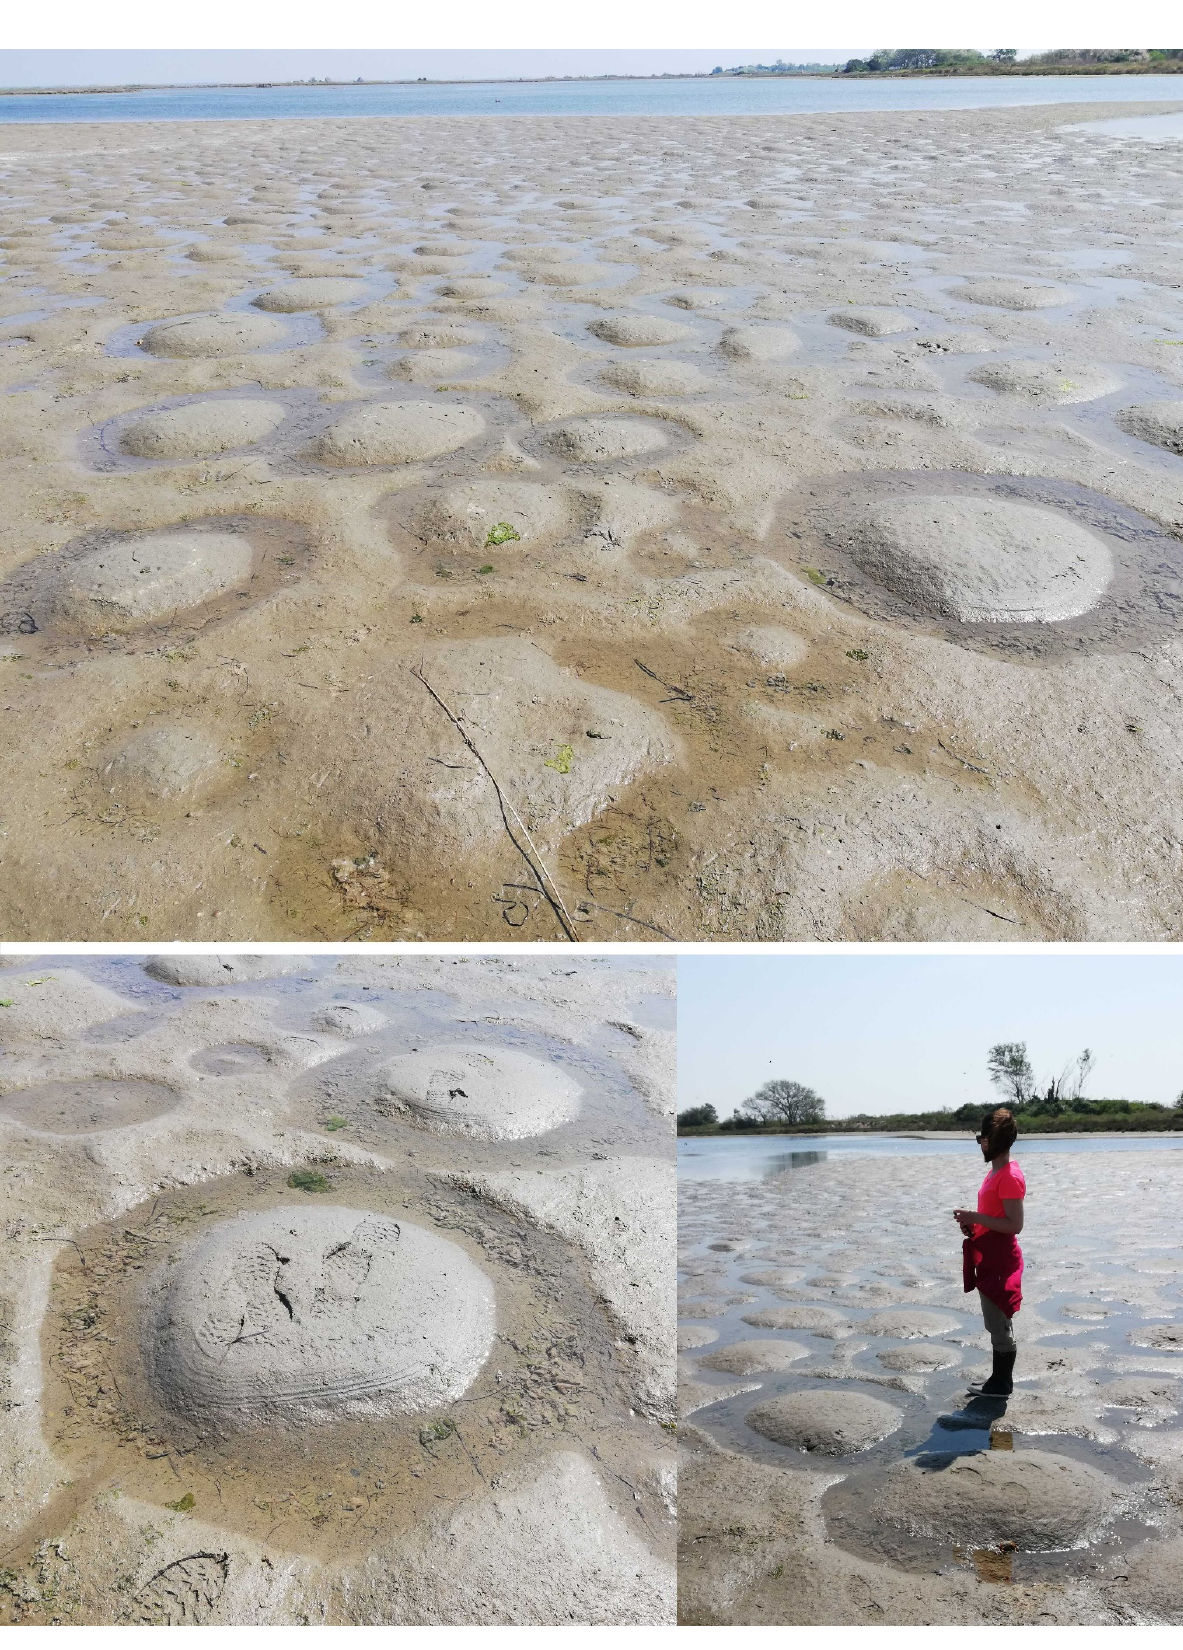
Figure 2. Photos of the aggregation of Greater Flamingo’s foraging structures.